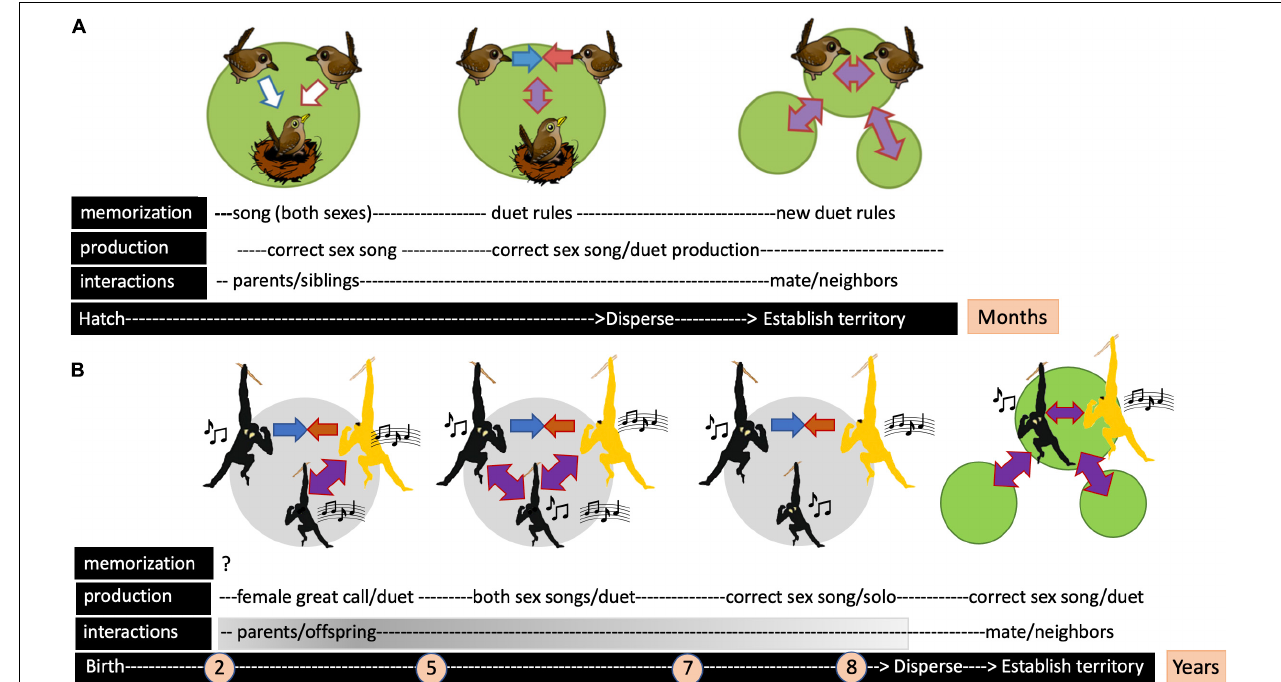
FIGURE 1 | Diagram illustrating the timing of song acquisition and the nature of social interactions that characterize the development of antiphonal duets in a songbird (canebrake wren) and a lesser ape (southern yellow-cheeked gibbon). (A) The songbird model of duet acquisition in which young birds first memorize sounds heard from both parents acting as tutors, then “learn” duet codes during mutual singing sessions with a same-sex parent; following post-natal dispersion, mature individuals “re-learn” to combine song elements with a new mate, performing a duet which is used to advertise territory ownership and/or pair bond strength. (B) The lesser ape model of duet acquisition in which a young male first develops a female-like great call while co-singing with his mother until reaching sexual maturity (3–5 years). Sexually mature daughters – not shown in the diagram – have acquired the basic pattern of the maternal song (Merker and Cox, 1999), which is then perfected during co-singing sessions with the mother until leaving the parental group (Koda et al., 2013). Mother-son vocal interactions continue at a decreasing rate (gray gradient) until adolescence. From 5 to 7 years, sons utter both male and female song elements and subsequently discard the female-like great call from their repertoire, retaining only male song (coda). The male coda consists of a multi-modulation note and a staccato note that develop in that sequence until at least 8 years of age (Hradec et al., 2021). In the absence of experimental evidence, gibbons are not considered vocal learners, but the memorization phase remains questionable. Arrows denote vocal interactions. Note the difference in the timeline between the two model systems. Green circles refer to observations made in the wild; gray circles depict events observed in zoo animals [adapted from Rivera-Cáceres and Templeton (2019), Hradec et al.